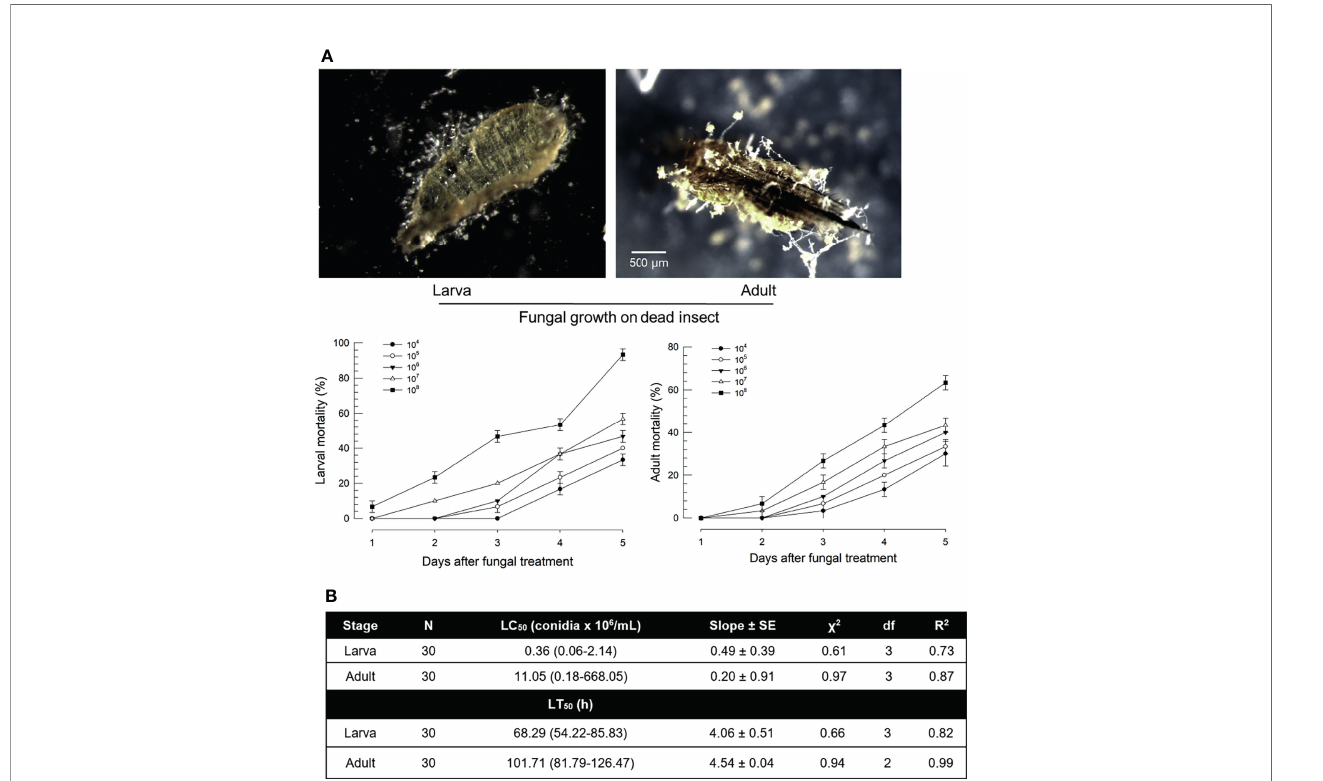
FIGURE 1 | Virulence of B. bassiana , an entomopathogenic fungus, to F.occidentalis . (A) Insecticidalactivities of B. bassiana at differentdoses (conidia/mL)to larvae and adults at different time points. Seed kernels were dippedin 1 mLofconidial suspensions fromeach concentration for 5 min and leftto dry at 25°C for 10 min under a clean bench.The photos were taken to con fi rmthe fungal growth from dead insects at 10 daysafter the fungal treatment. Control without fungi did not show anymortality during this assay. (B) Median lethal concentration (LC 50 ) andmedian lethal time (LT 50 ) offungaltoxicity.Second instar larvae (L2) and adults were used inthis bioassay.To estimate median lethal concentrations(LC 50 s), a fungal concentration of1×10 6 conidia/mL was used for each testsample. Median lethal times (LT 50 s) were estimated with the same fungal concentration. An experimental unit (Petri dish)contained 30 larvae or adults. The Petri dishwas sealed bypara fi lm. Each treatment was replicated three times. Both experiments were performed under a constant temperature of 25 ± 1°Cwith relative humidity (RH) of 75 ± 5% using a saturated solution of NaCl ina